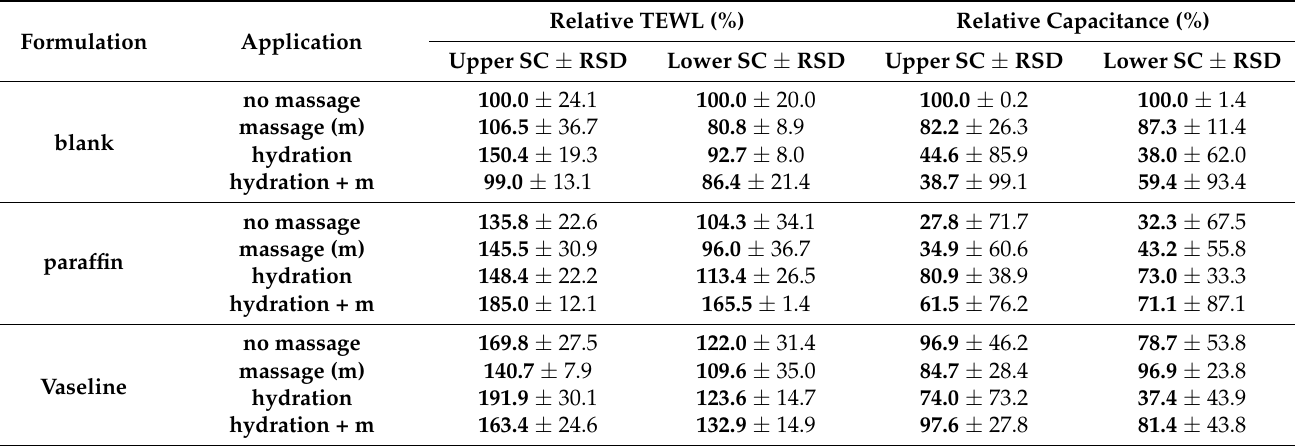
Table 1. Influence of formulation, application, and skin condition on skin hydration. Results are expressed as relative values, i.e., the values obtained from the untreated skin were used as a benchmark control and were set to 100%. The values obtained for the other skin areas were related to these values and are presented as relative TEWL (%) and capacitance (%) ± relative standard deviation